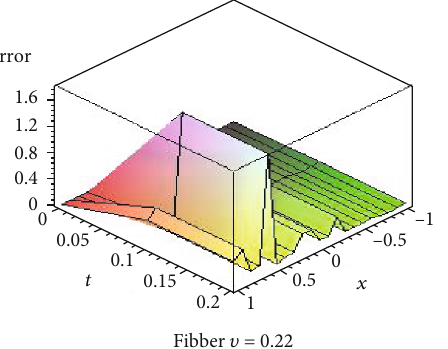
Figure 9: The value absolute error by PNM at N = 20 and T = 0 : 2 .